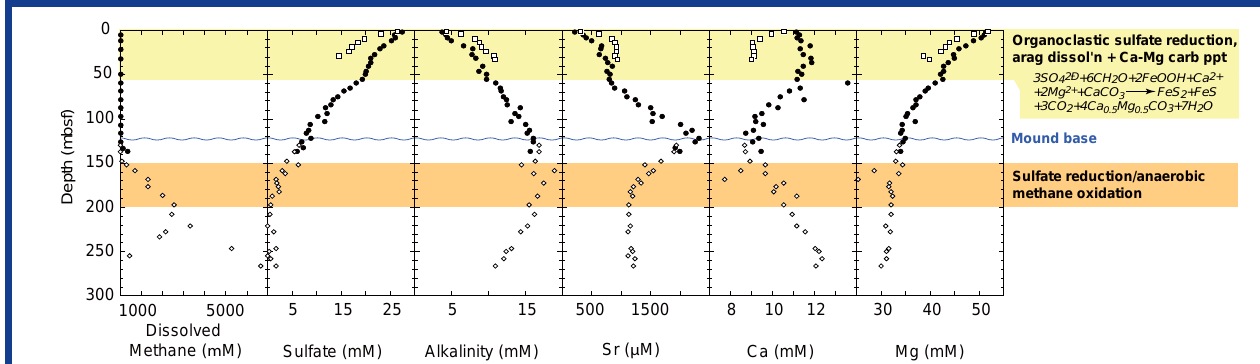
Figure 8. Geochemical pro fi les of interstitial water collected from Site U1317 (Challenger Mound). The yellow bar shows the zone of sulfate reduction and carbonate diagenesis in the coral-bearing upper meters of mound sediment. An equation linking organic matter decay, pyrite formation, and carbonate diagenesis is also shown. Sulfate reduction associated with anaerobic oxidation of methane, as shown by the orange bar, occurs below the mound